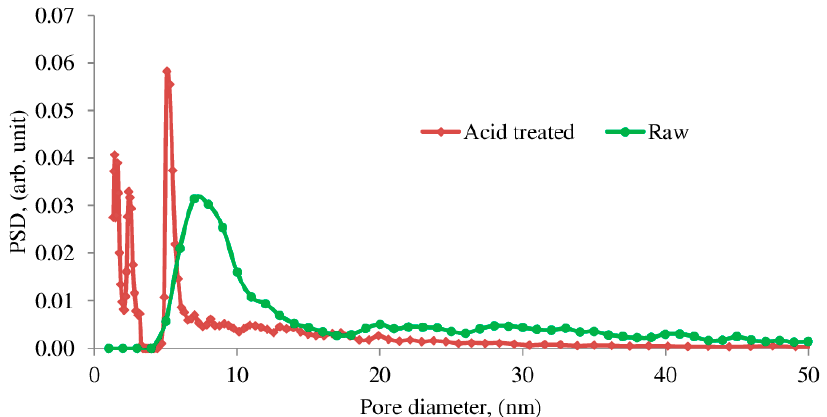
Figure 7. Pore-size distribution by application of the non-local density functional theory (NLDFT) model.